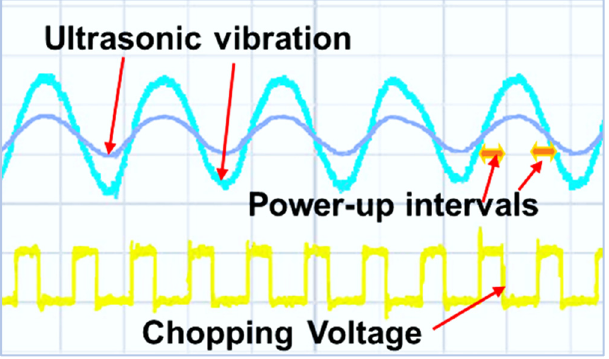
10 of 19 Figure 8. Overview of the Machining system. Through the multi-dimensional ultrasonic control system, the workpiece system res- onated and rotated with the normal direction of the machining surface. By modulating the multidimensional rotating ultrasonic parameters, the “electrolysis-discharge” ma- chining was produced between the electrode and the workpiece using the ultrasonic ex- citation effect, and the “on and off“ of the machining power supply was controlled by the output of the pulse detection module, and the feedback signal was generated by the com- puter based on the needs of the machining state. The feedback signal was adjusted and controlled in real time by the computer according to the needs of the machining status which could ensure the small gap machining and avoid the machining short-circuit at the same time. Before conducting the experiment, it was necessary to ensure that the ultrasonic sys-